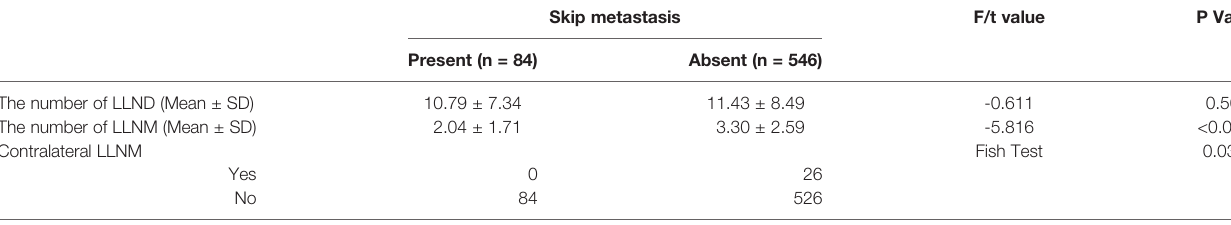
TABLE 3 | Comparison of LLN between skip metastasis and non-skip metastasis with PTC.